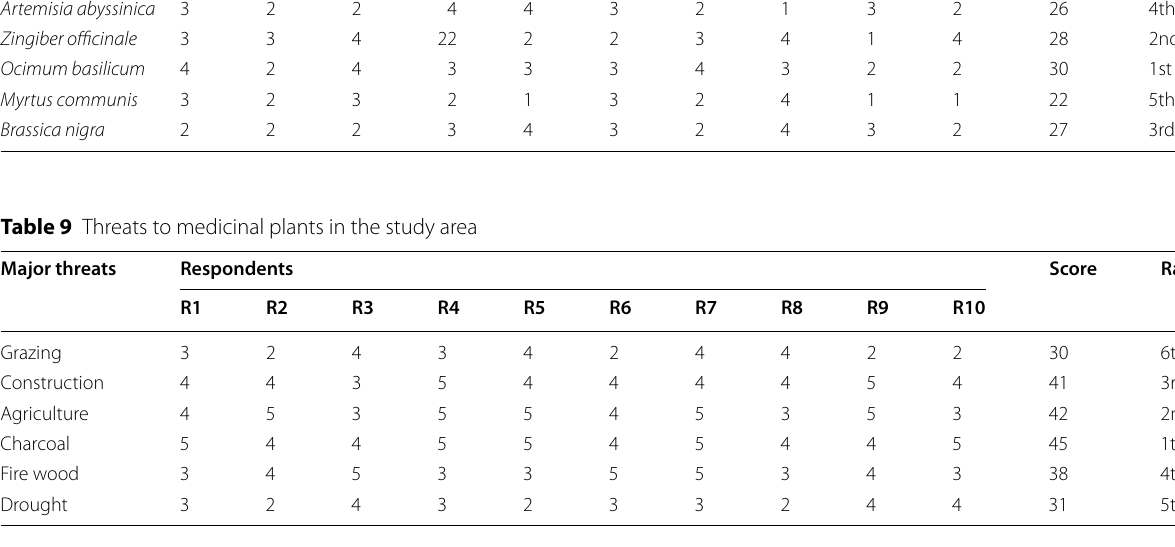
Artemisia abyssinica 3 Zingiber officinale Ocimum basilicum Myrtus communis Brassica nigra